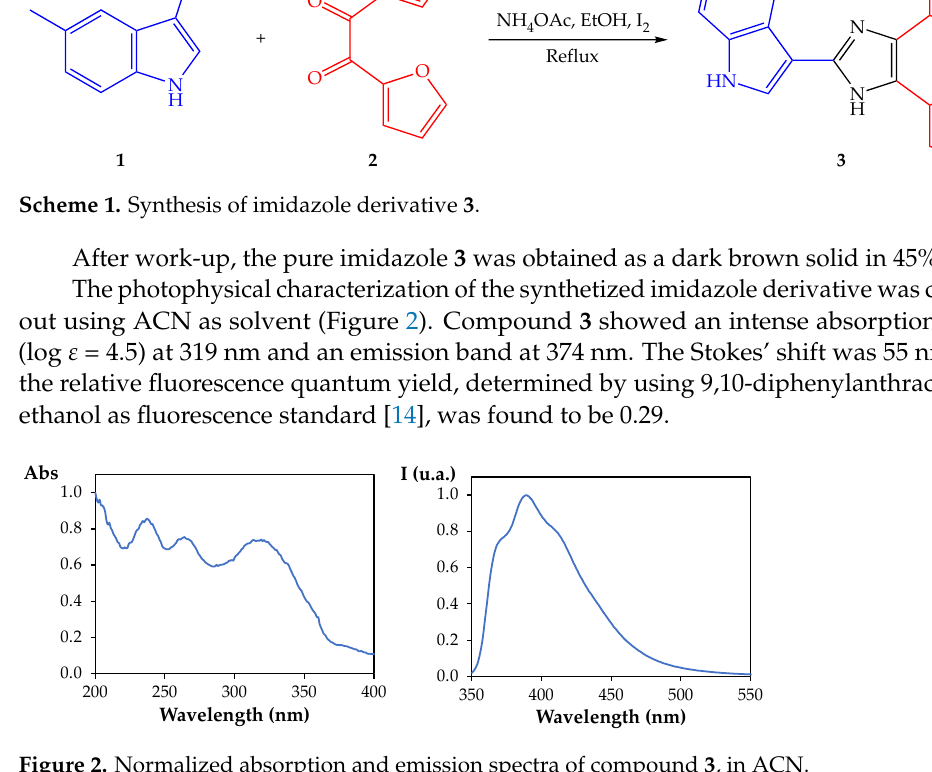
Figure 2. Normalized absorption and emission spectra of compound 3 , in ACN.